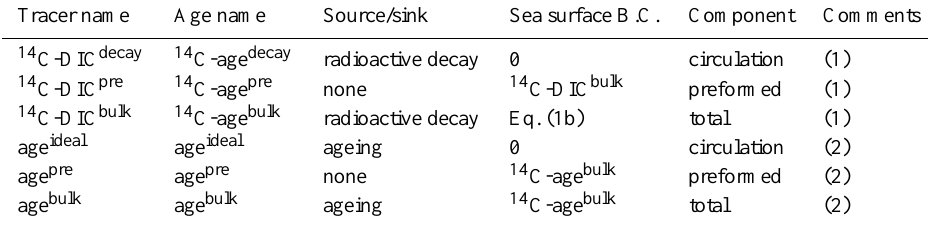
Table 1. Tracers.